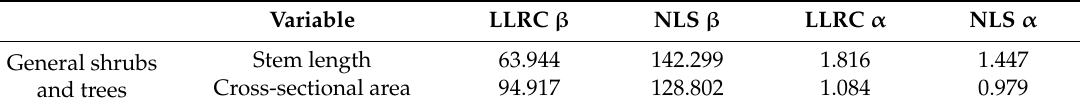
Table 7. Regression coe ffi cients to predict total AGB for general shrubs and trees with LLRC and NLS.